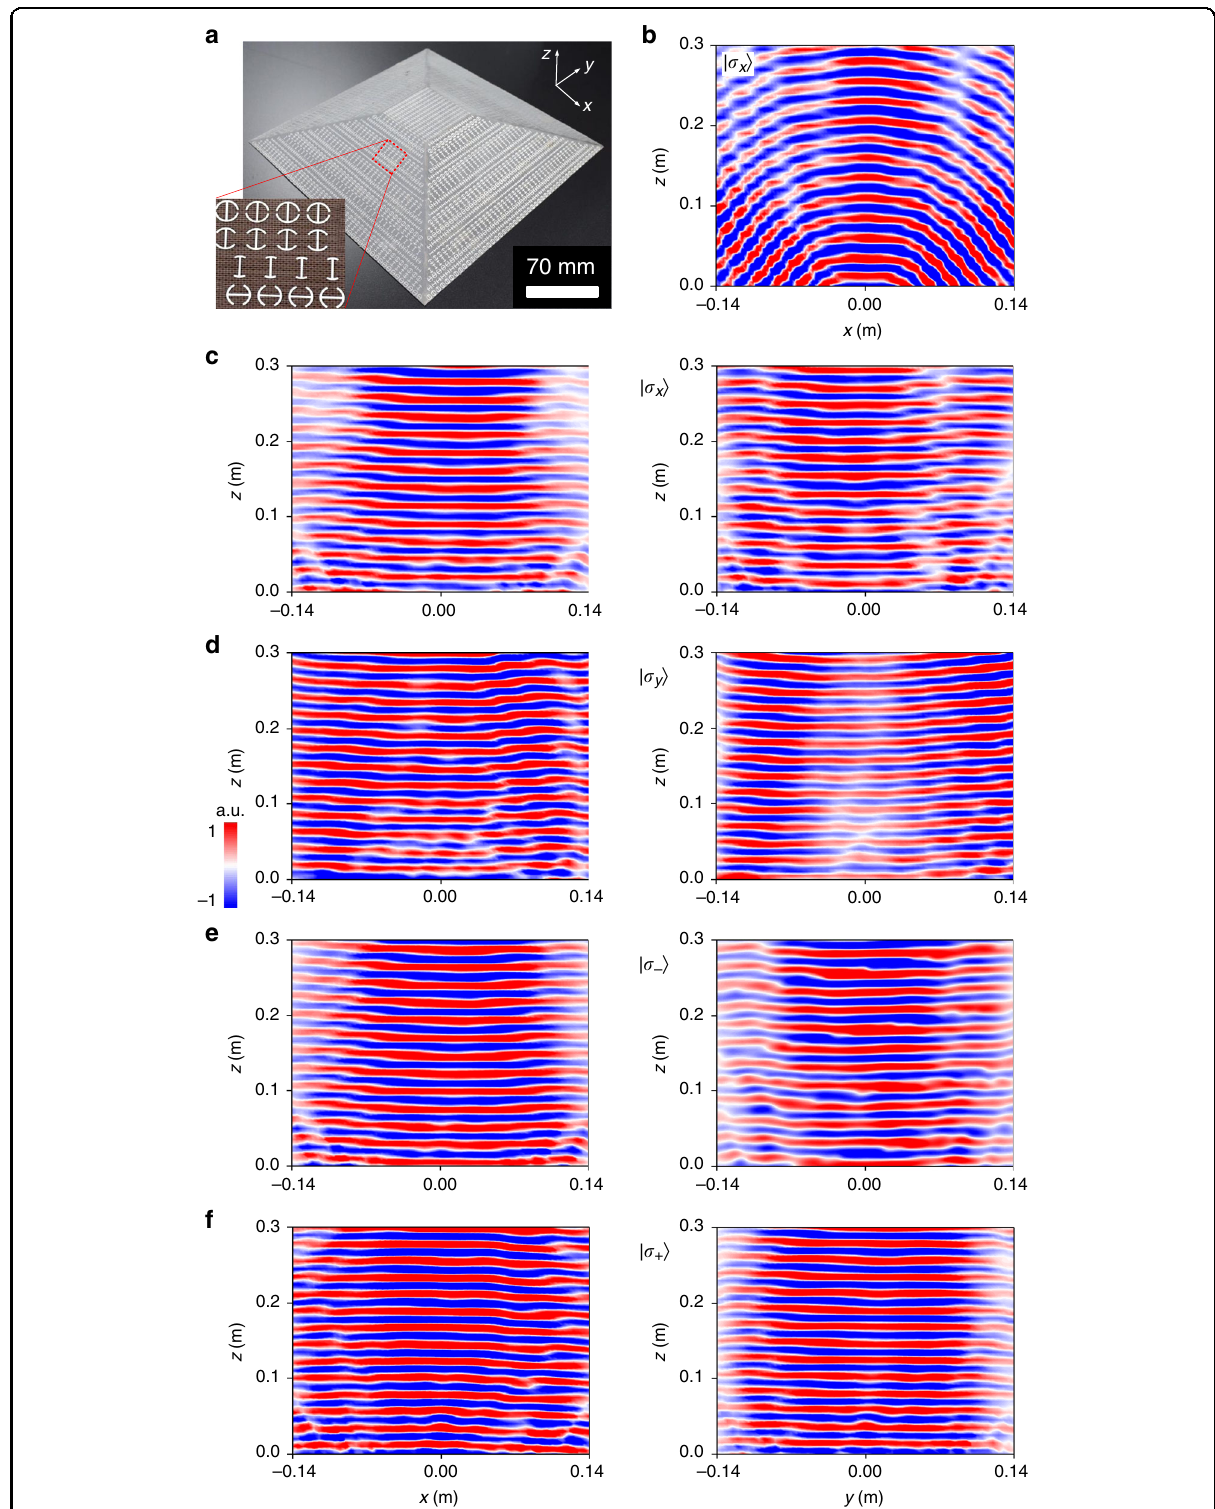
Fig. 5 Experimental characterization of the pyramid bump and full-polarization conformal-skin cloak at 15.5 GHz under normal incidence. a Photograph of the fabricated sample with the magni fi ed picture shown in the inset. b – f NF copolarized E - fi eld distributions of the bump under σ j ið b Þ and ( c – f ) metasurface cloak under σ x